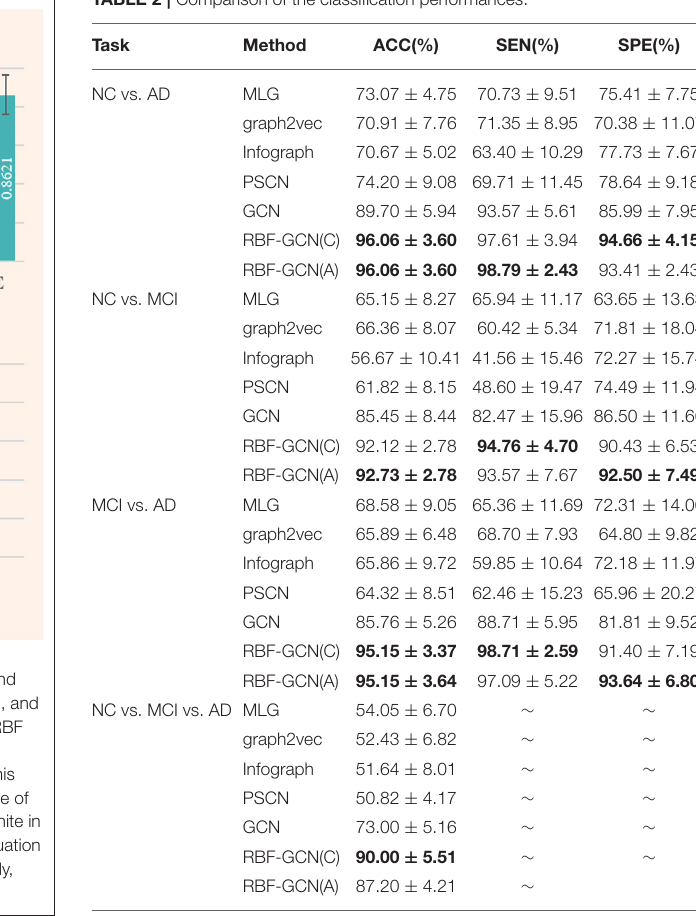
TABLE 2 | Comparison of the classification